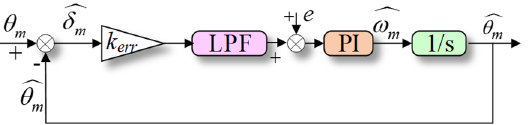
Figure 3. The closed-loop system, considering the current sampling error.